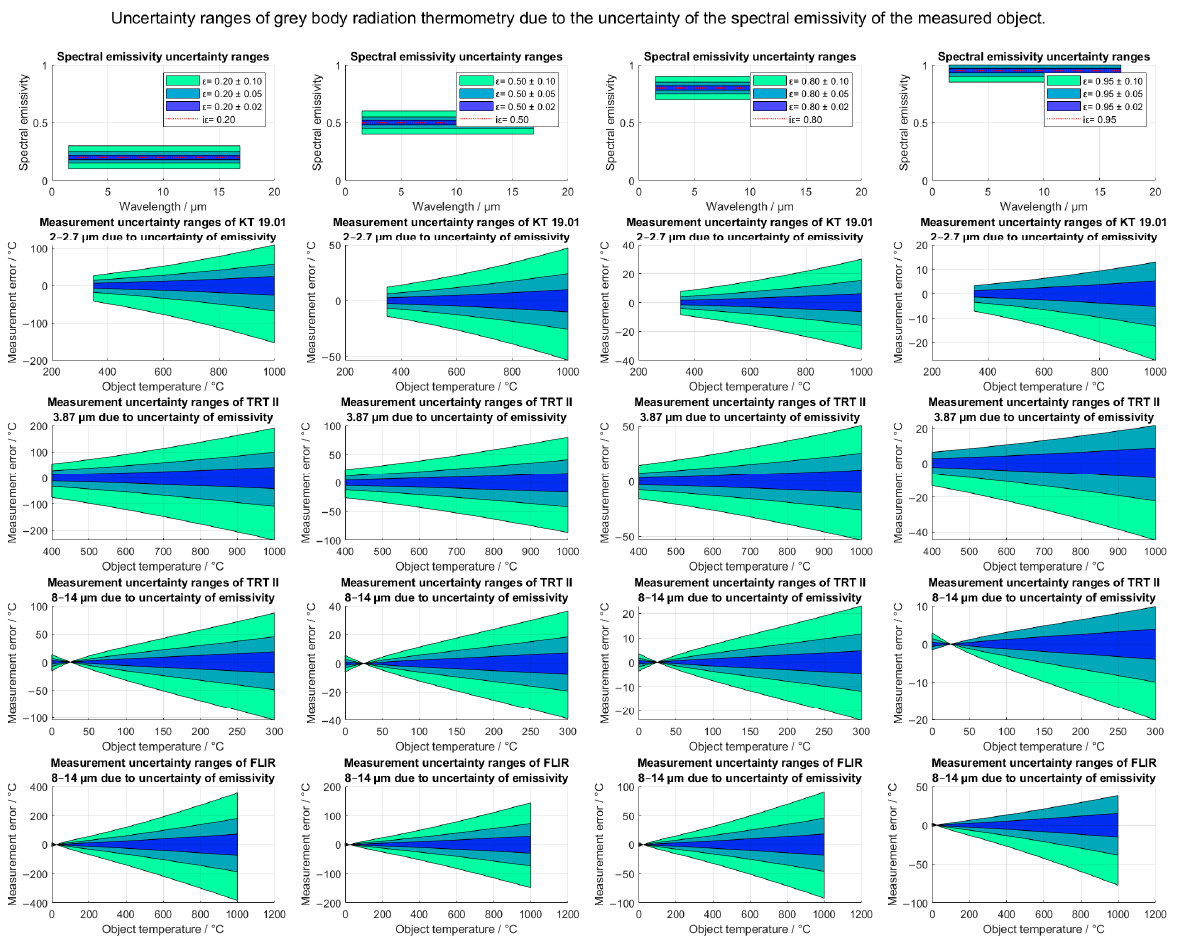
Figure 18. Measurement uncertainty intervals for grey body radiation thermometry of surfaces with di ff erent spectral emissivities and homogeneities. The uncertainty contributions are calculated at 25 °C environmental temperature and correspond to the probability of occurrence of the spectral emissivity within the speci fi ed uncertainty interval.